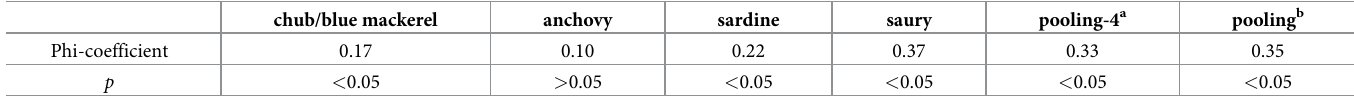
Table 1. Coefficients (Phi-coefficient value and Fisher’s exact test) of detection performance among the five target fish. chub/blue mackerel